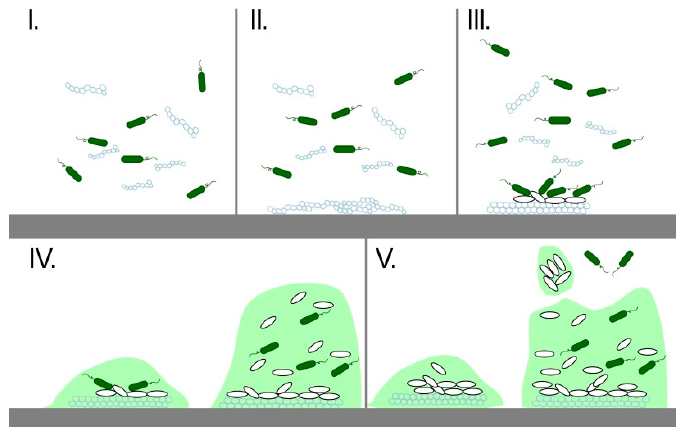
Figure 3. Five steps of biofilm formation: I. Host products ( blue chains ) are attached to the biomaterial, II. Creation of organic film, III. Attachment of microorganisms ( green lozenges ), creating of extracellular polymeric matrix ( white lozenges ), IV. Development of the biofilm, V. The release of cells from the biofilm. Table 1. Host products affecting bacterial attachment to a biomaterial [74].